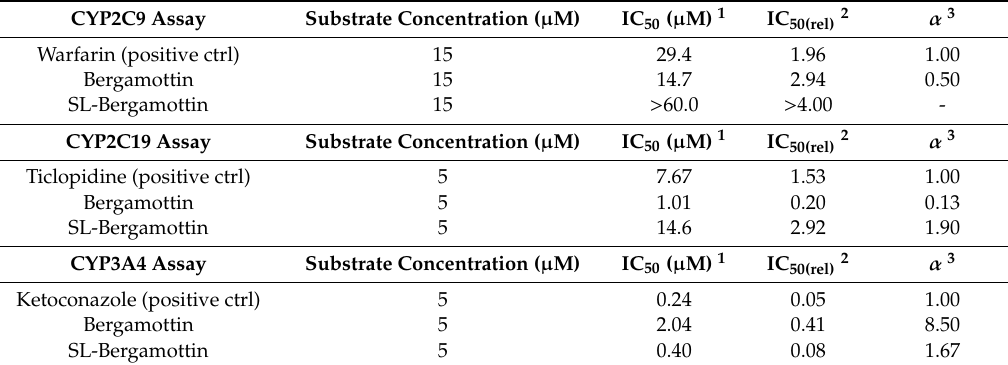
Table1. InhibitionoftheCYP2C9, CYP2C19,